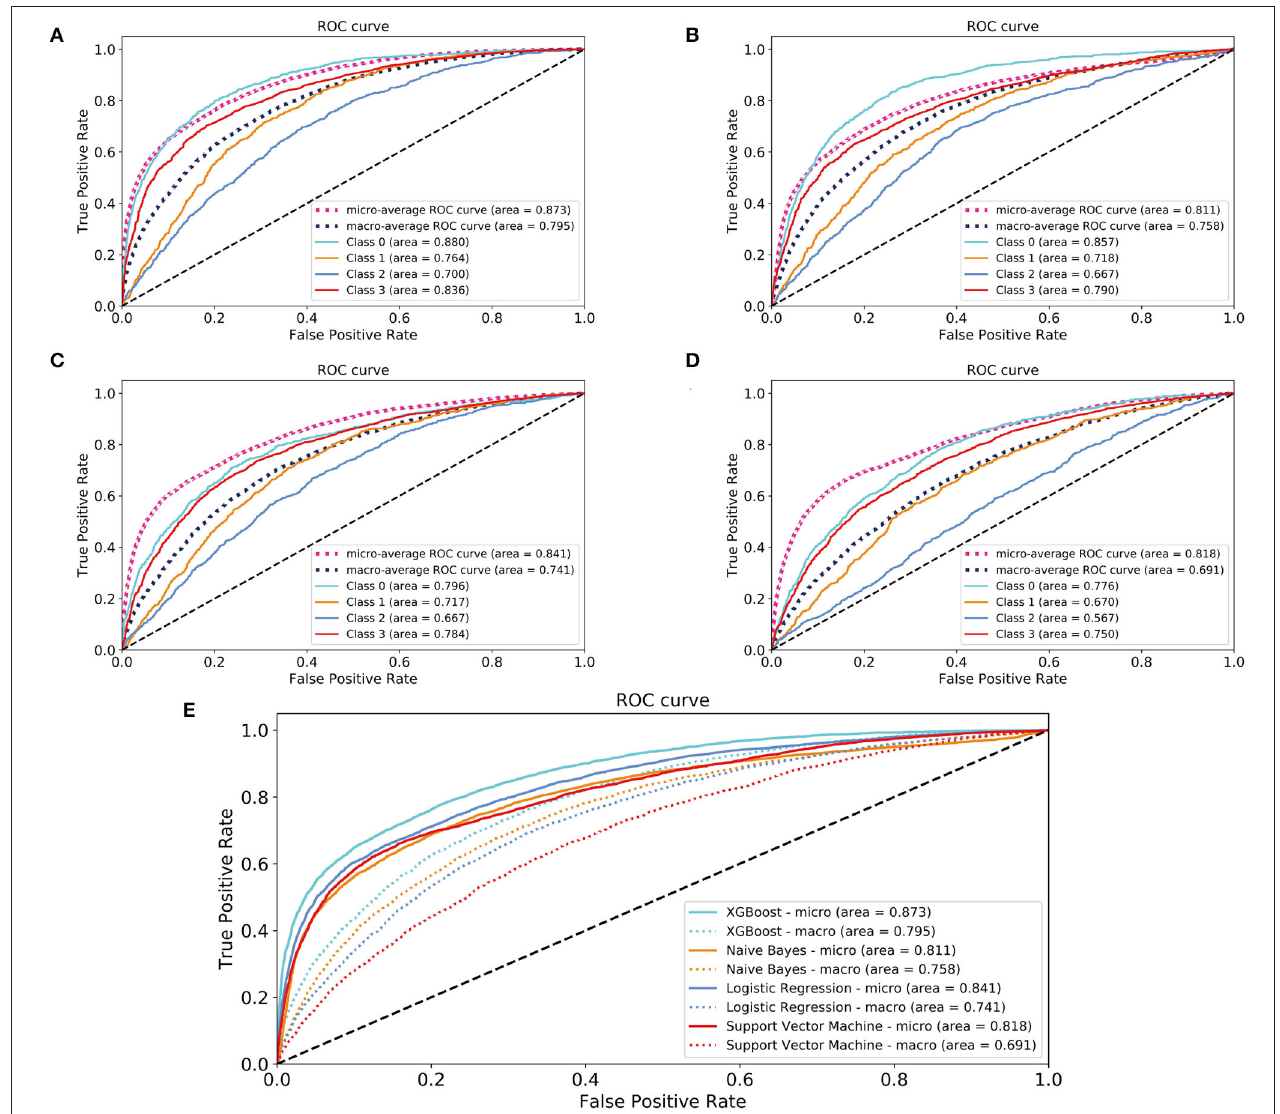
FIGURE 2 | Areas under the receiver operating characteristic curves for evaluating the classification performance of the different models. (A) XGBoost model; (B) naïve Bayes model; (C) logistic regression model; (D) support vector machine model; (E) a comparison of four models. Class 0: time to death < 30 days; Class 1: